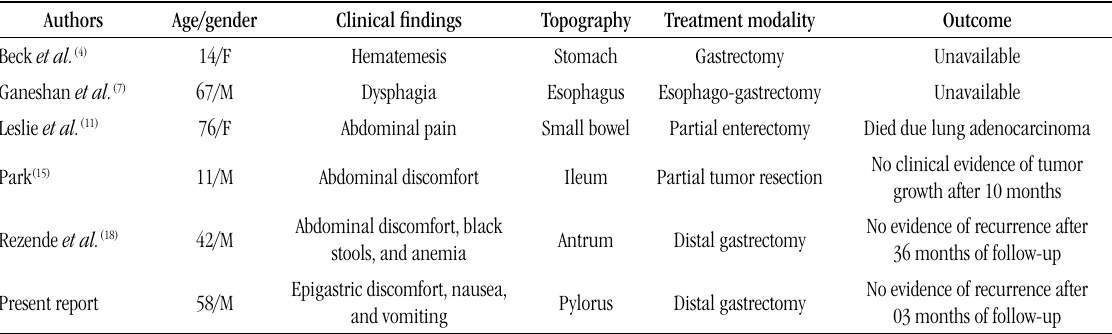
Table – Summary of some published cases of gastrointestinal